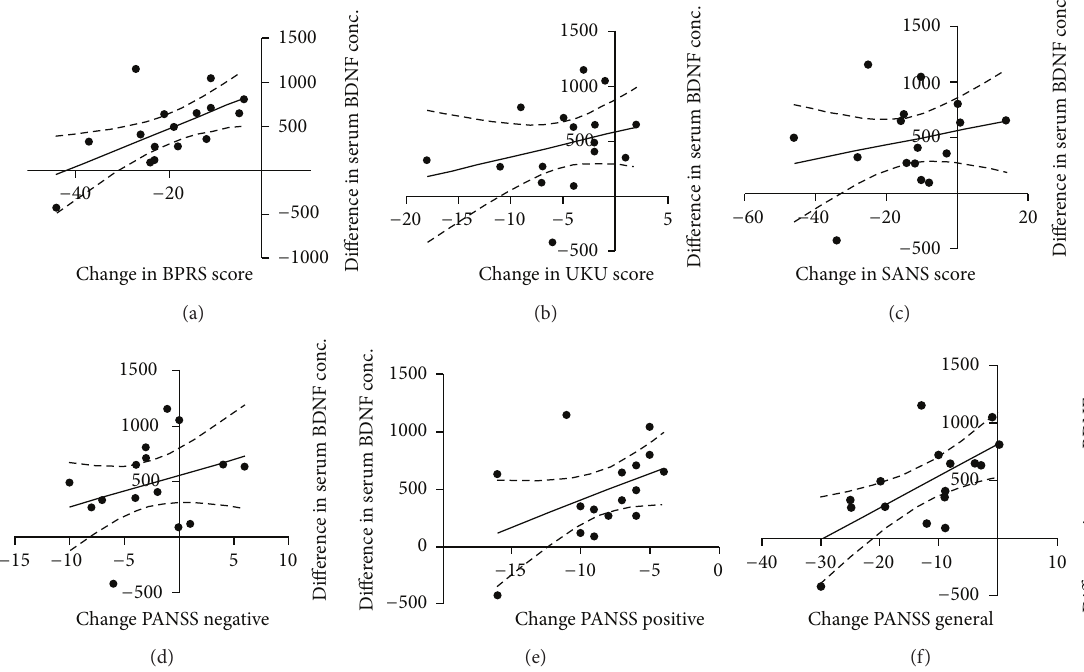
Figure 2: Relationship between changes in serum BDNF concentrations with changes in outcome measures. There were significant positive correlations between serum BDNF levels and improved scores on the BPRS (a) and PANNS general (f). There were no significant correlations for changes in scores of UKU (b), SANS (c), PANSS negative (d), and PANSS positive (e) with the difference in BDNF levels across both time points.